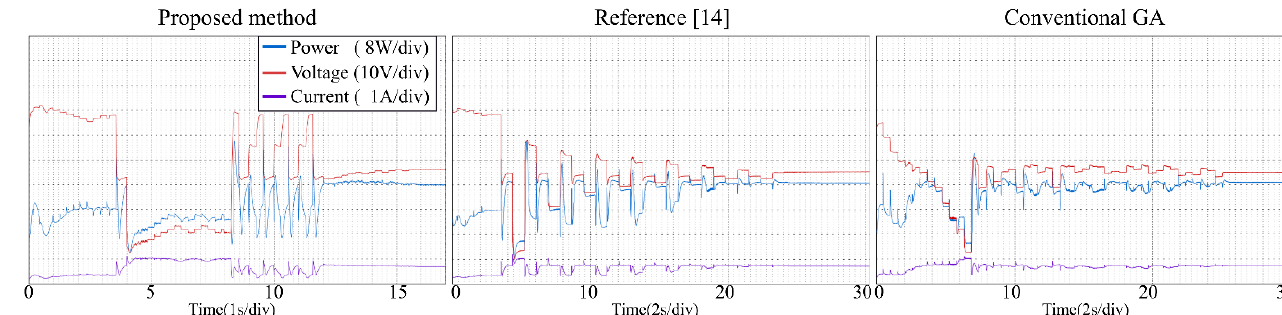
Figure 14. Tracking process—Pattern 2.